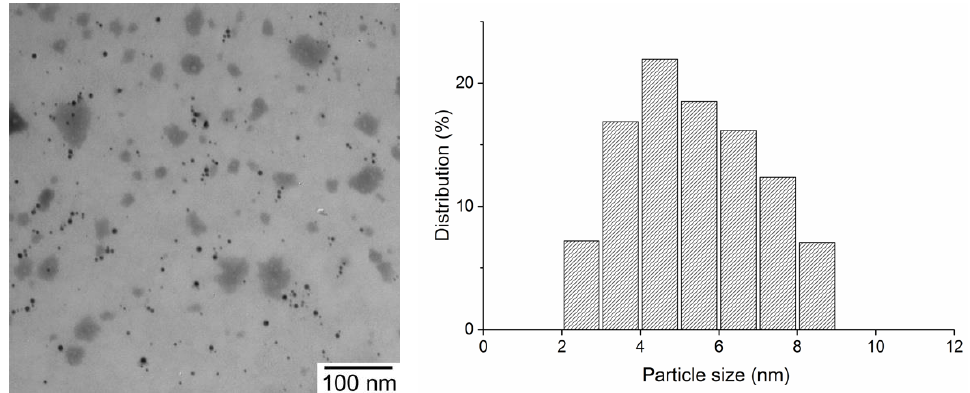
Figure 7. Transmission electron micrograph and respective histogram of AgNPs nanocomposite.